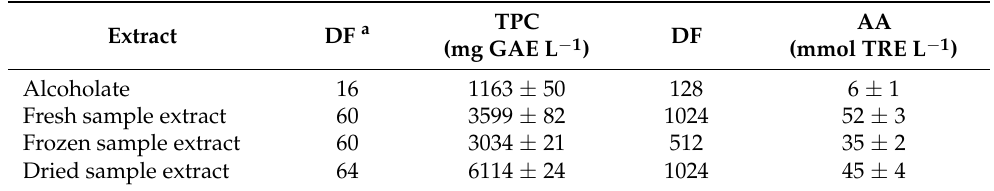
Table 1. Mean TPC and AA values for the studied extracts: alcoholate, ultrasonic extracts from fresh, frozen, and dried samples.